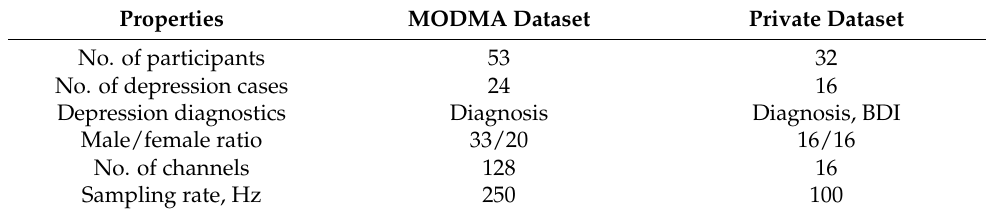
Table 1. Properties of datasets with data.